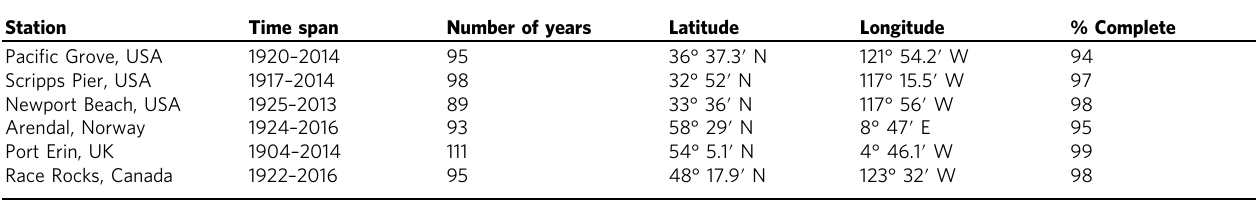
Table 1 Century-long daily in situ records of ocean temperatures